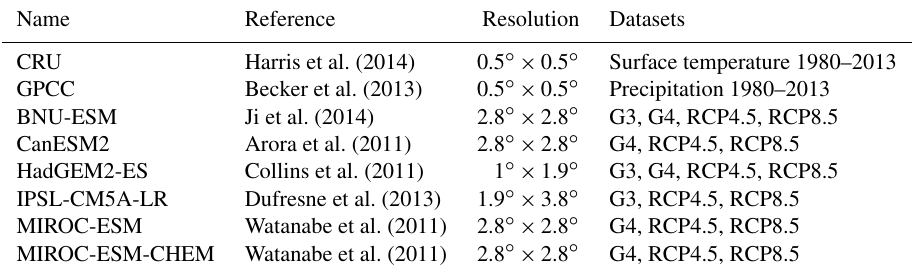
Table 3. Climate models and datasets used in this